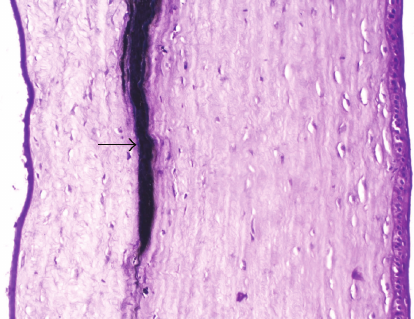
Figure 5: Enucleated rabbit eye with corneal staining .